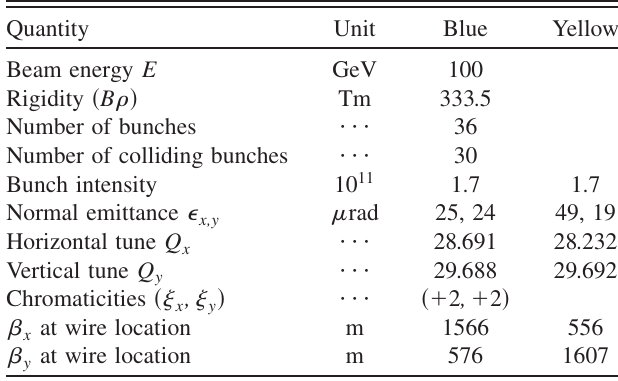
TABLE VI. Relevant RHIC beam and lattice parameters for experiments with proton